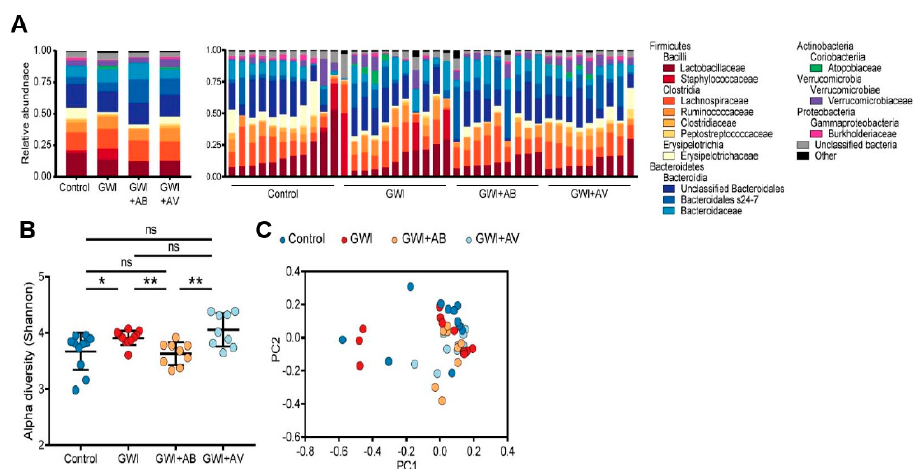
Figure 2. Gut bacterial dysbiosis induced by Gulf War chemical exposure is altered by antibiotics but not by antiviral treatment. ( A ) The relative abundance of bacteriome is shown of the treatment group average (left) and by individual mice (right). ( B ) Alpha diversity (Shannon index) of bacterial taxa is shown. Statistical significance was assessed by Mann–Whitney U test; * p < 0.05, ** p < 0.01, ns not significant. ( C ) Principal coordinate analysis (PCoA) of unweighted Bray–Curtis distance of bacteriome is shown. Treatment groups are indicated respectively.